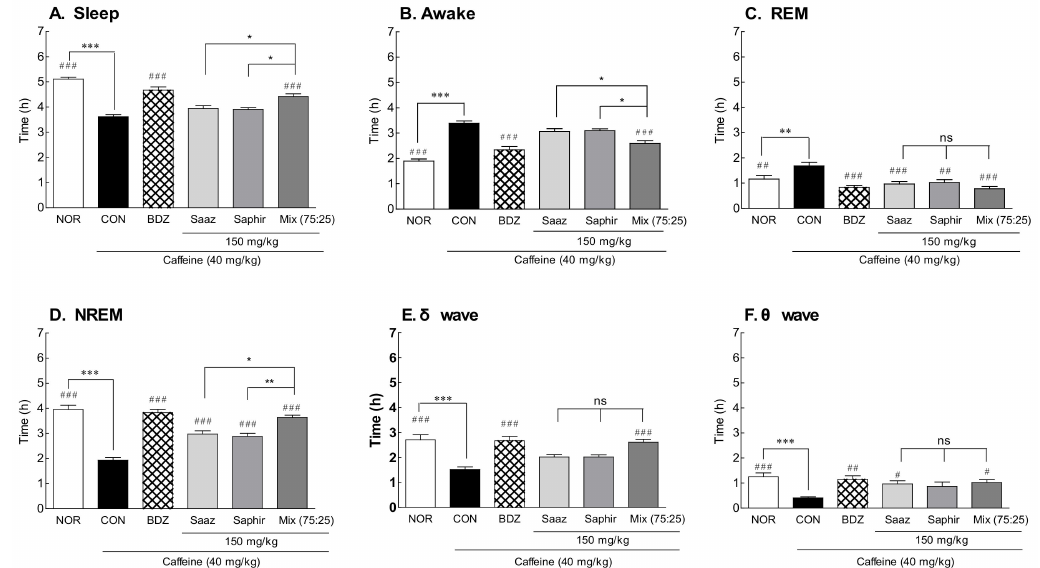
Figure 3. Effects of hops (Saaz, Saphir, and Saaz–Saphir mixture) on electrophysiologic patterns in rat-induced insomnia by caffeine. Electroencephalography (EEG) analyses were conducted for 4 days ( A ) Sleep time, ( B ) awake time, ( C ) duration of REM, ( D ) duration of NREM, ( E ) δ wave of NREM, and ( F ) θ wave of NREM. NOR: the 0.9% NaCl (physiological saline) group (normal control), CON: caffeine control (40 mg/kg), BDZ: Benzodiazepine treatment (positive control, 200 µ g/kg), Saaz (120 and 150 mg/kg), Saphir (120 and 150 mg/kg), and Saaz–Saphir mixture (75:25, 120 and 150 mg/kg). Values are presented as the mean ± standard error of the mean (SEM) for each group, n = 8. Asterisks indicate significant differences: *** p < 0.001 vs. NOR; * p < 0.05 and ** p < 0.001 vs. Saaz–Saphir mixture; and # p < 0.05, ## p < 0.01, and ### p < 0.001 vs. CON by Tukey’s multiple comparison